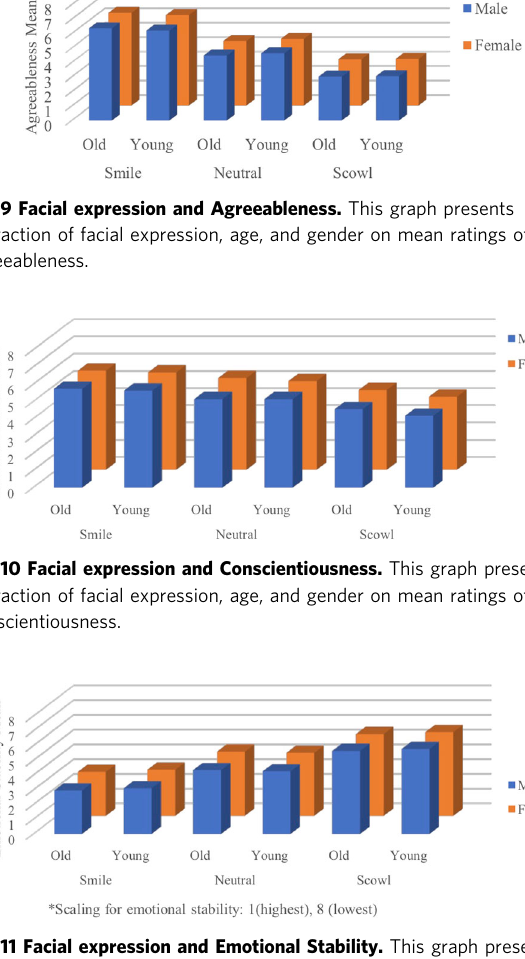
interaction of facial expression, age, and gender on mean ratings of Emotional Stability.